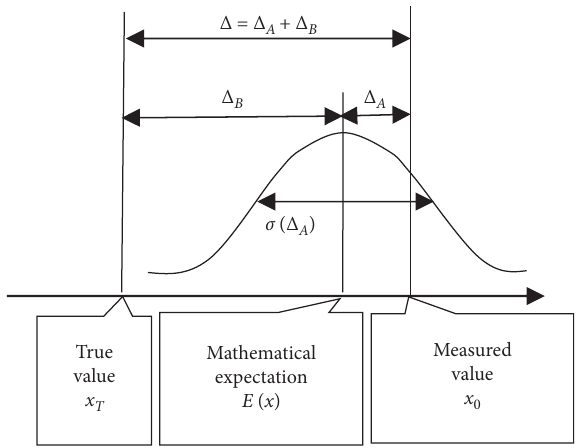
Figure 2: Schematic diagram in the new concept theory.